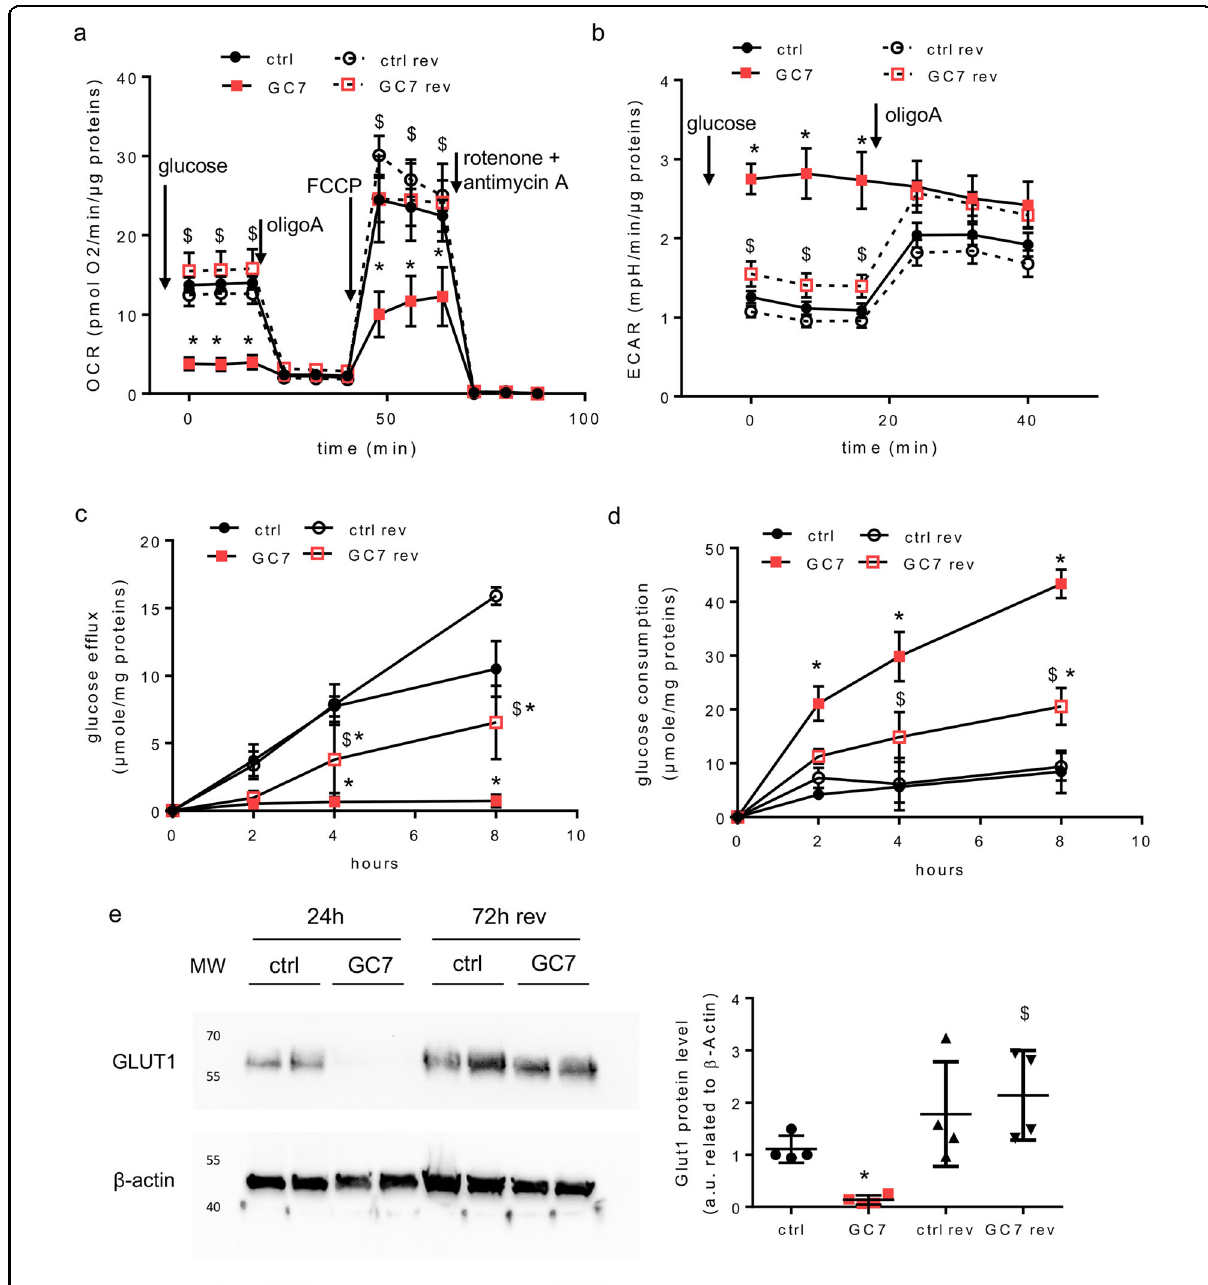
Fig. 6 The effect of GC7 is fully reversible. Con fl uent PCT cells were treated or not with 30 µM GC7 for 24 h and then GC7 was removed and cells were maintained for an additional period of 72 h and analysed. a , b Cells were analysed using Seahorse technology to evaluate oxygen consumption ( a ) and extracellular acidi fi cation ( b ) in the presence of 10 mM glucose. Addition of other compounds are indicated. Dots displayed mean ± SD of three independent experiments. * p < 0.05 evaluated using Mann – Whitney. c At the end of treatment cells were deprived in glucose and the ef fl ux of glucose was measured in the next 8 h. d Measurement of cell glucose consumption corresponding to the difference between measurement of the media glucose content decrease (in the presence of glucose in media) and media glucose content increase (after glucose deprivation). Dots displayed mean ± SD of three independent experiments. * p < 0.05 evaluated using Mann – Whitney tests. “ Ctrl rev ” are control cells at 72 h without GC7 treatment and “ GC7 rev ” correspond to cells 72 h after GC7 removal. “ Ctrl ” and “ GC7 ” are cells analysed after 24 h. e Western blot analysis of GLUT1 in membrane-enriched protein lysate from PCT cells following a 24 h GC7 treatment (30 µM) and after 72 h of GC7 washout (72 h rev). β -actin was used as a loading control. MW molecular weight. * p < 0.05 evaluated using Mann – Whitney test.